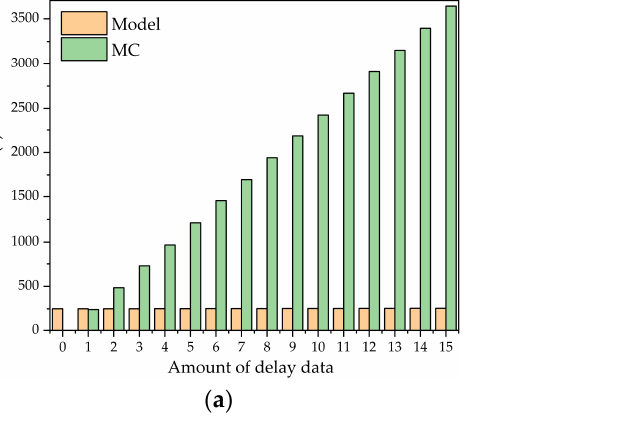
Figure 15. Time consumption varies with the amount of data. ( a ) Comparison of the model and SPICE MC simulation; ( b ) enlarged view of the model calculation time in ( a ).